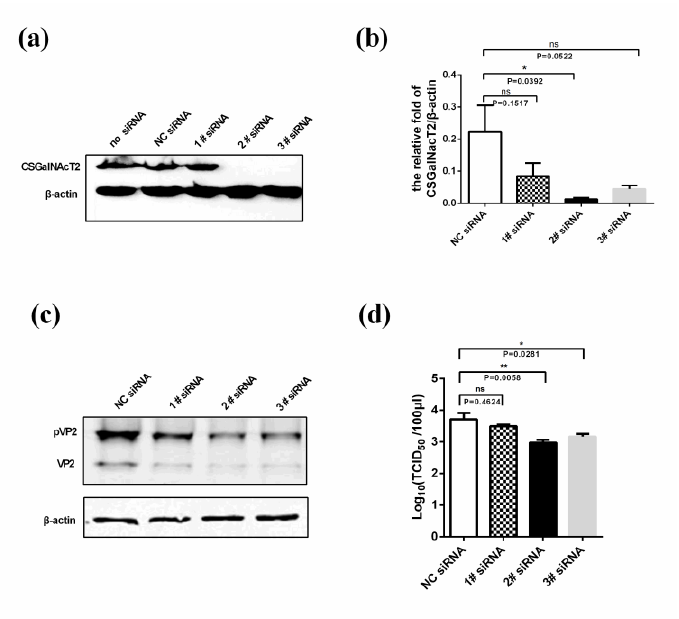
Figure 5. Knockdown of CSGalNAcT2 inhibits IBDV growth. ( a ) Interference efficiency of siRNAs against exogenous CSGalNAcT2. In DF1 cells, 2 μg pCSGalNAcT2 was co-transfected with 100 pmol negative control siRNA (NC), 1# siRNA, 2# siRNA, or